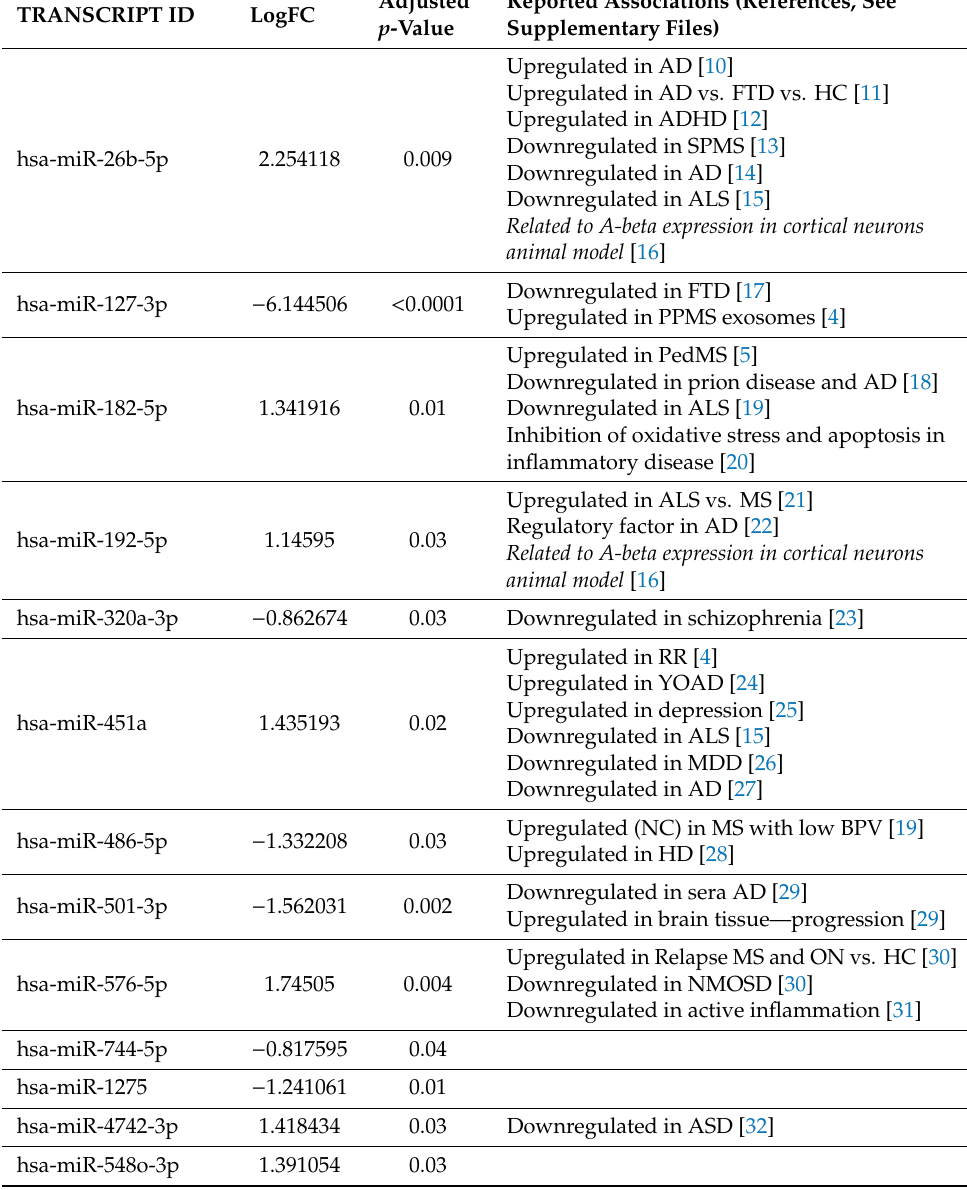
Table 2. miRNAs whose expression (logFC) results were statistically significantly di ff erent between the observational interval (adjusted p -value < 0.05) and their published associations with MS and / or other neurodegenerative